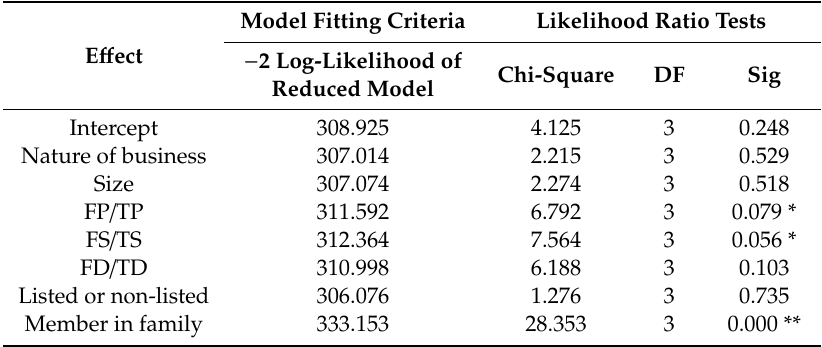
Table 6. The value of Chi-square statistic and the significance of the model variables.